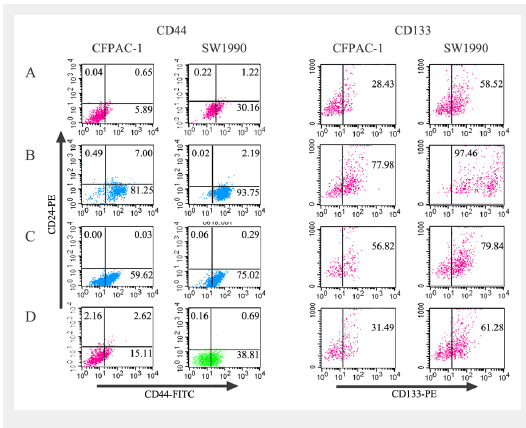
Cyclopamine down-regulates CSC markers in gemcitabine- resistant pancreatic cell lines. Parental CFPAC-1 and SW1990 cells and their gemcitabine-resistant counterparts were double- labelled with CD44-FITC and CD24-PE or CD133-PE alone. The percentages of CD44+ and CD133+ cells increased in gemcitabine- resistant cells (b), compared to parental cells (a). After treatment with 2 μM cyclopamine for 3 (c) and 7 (d) days, the percentage of CD44+ and CD133+ cells decreased to close to parental